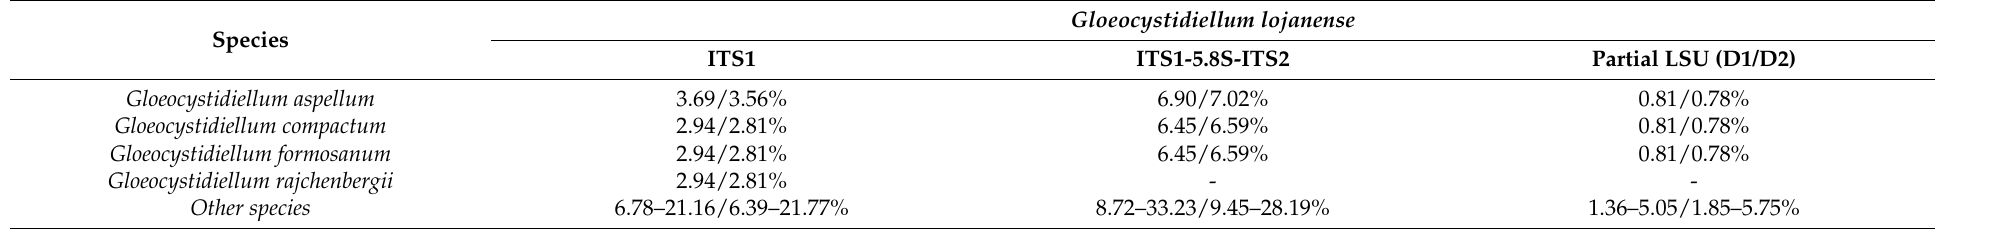
Table 4. Interspecific variation percentages between Gloeocystidiellum lojanense and phylogenetically sister